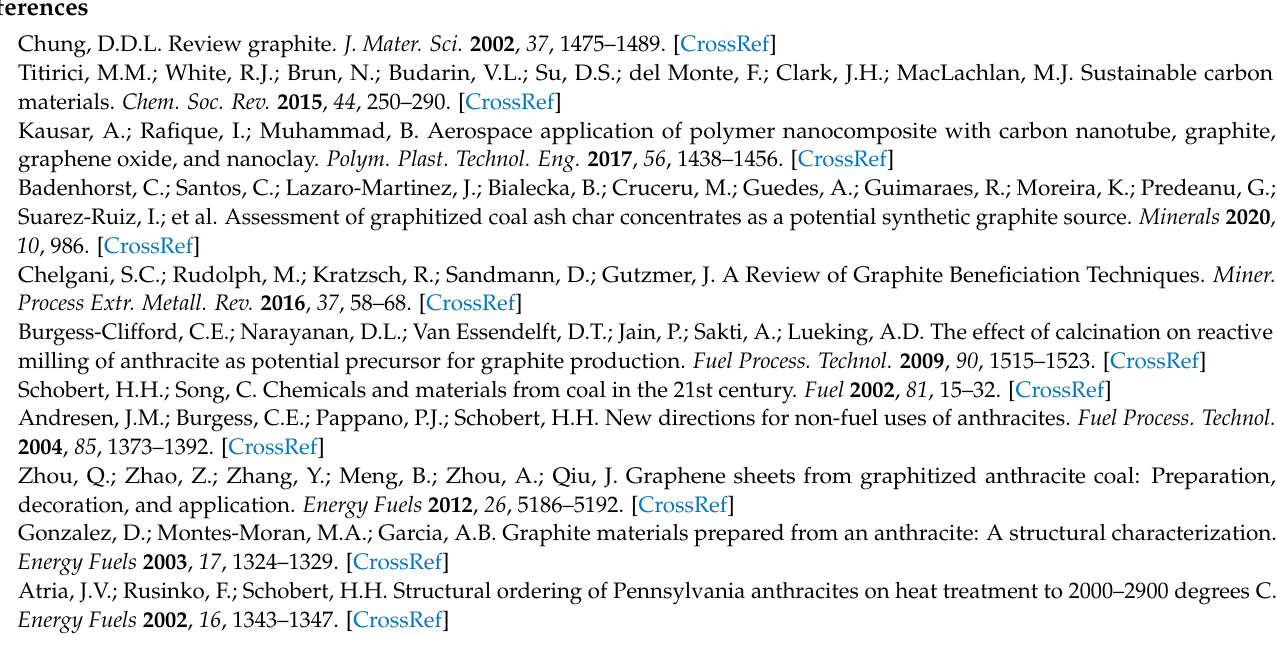
spectrum per sample. Figure S1. XRD pattern of raw lignite without further treatment. Figure S2. Curve fitting of XRD spectra of samples (a) 2-20, (b) 2-700, (c) 2-1300, (d) 4-20, (e) 4-700, (f) 4-1300, (g) 6-20, (h) 6-700, and (i) 6-1300 for (002) peak. Figure S3. The calculated asymmetry index (AI) of samples (a) 2-1300, (b) 4-1300, and (c) 6-1300 using the FWHM of (002) reflection. Figure S4. Second-order Raman spectra of lignite samples prepared at high pressure of (a) 2 GPa, (b) 4 GPa, and (c) 6 GPa. Figure S5. Peak fitting of second-order Raman spectrum of samples (a) 2-1300, (b) 4-1300, and (c) 6-1300. Figure S6. SEM images of (a) raw lignite and (b) lignite sample pyrolyzed at 700 ◦ C in a hori-zontal tube